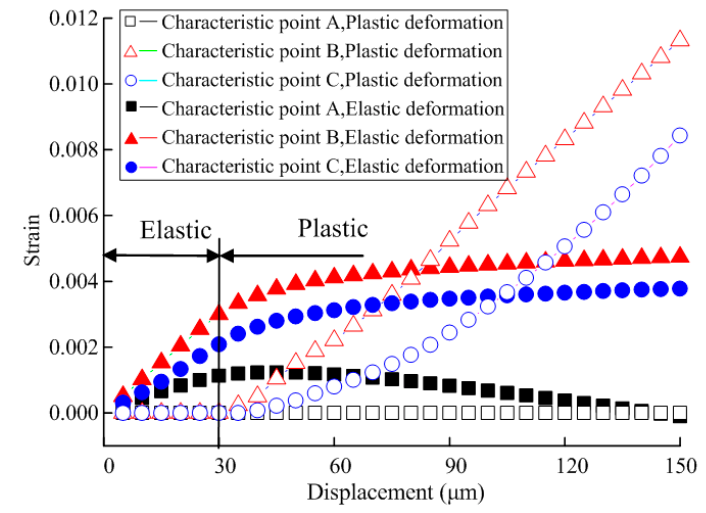
Figure 10. Displacement-dependent variation for strain of the specimen under combined load.